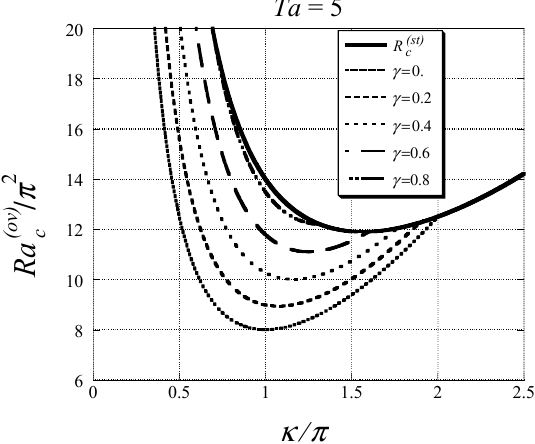
Figure 14. Stability curves for overstable gravity driven convection in a rotating porous layer heated from below ( γ = Va / π 2 , R = Ra g / π 2 ). [42]. (Reproduced with permission from Cambridge University Press.)